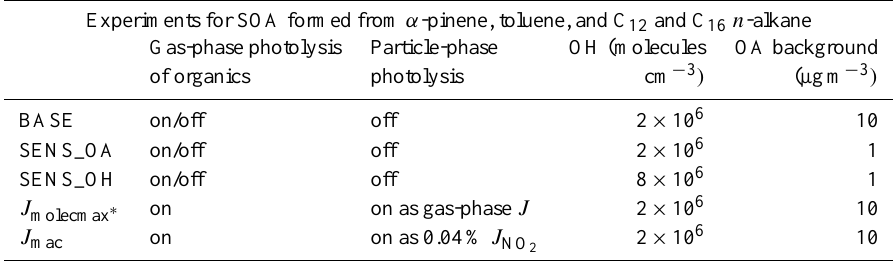
Table 2. Description of GECKO-A simulations.